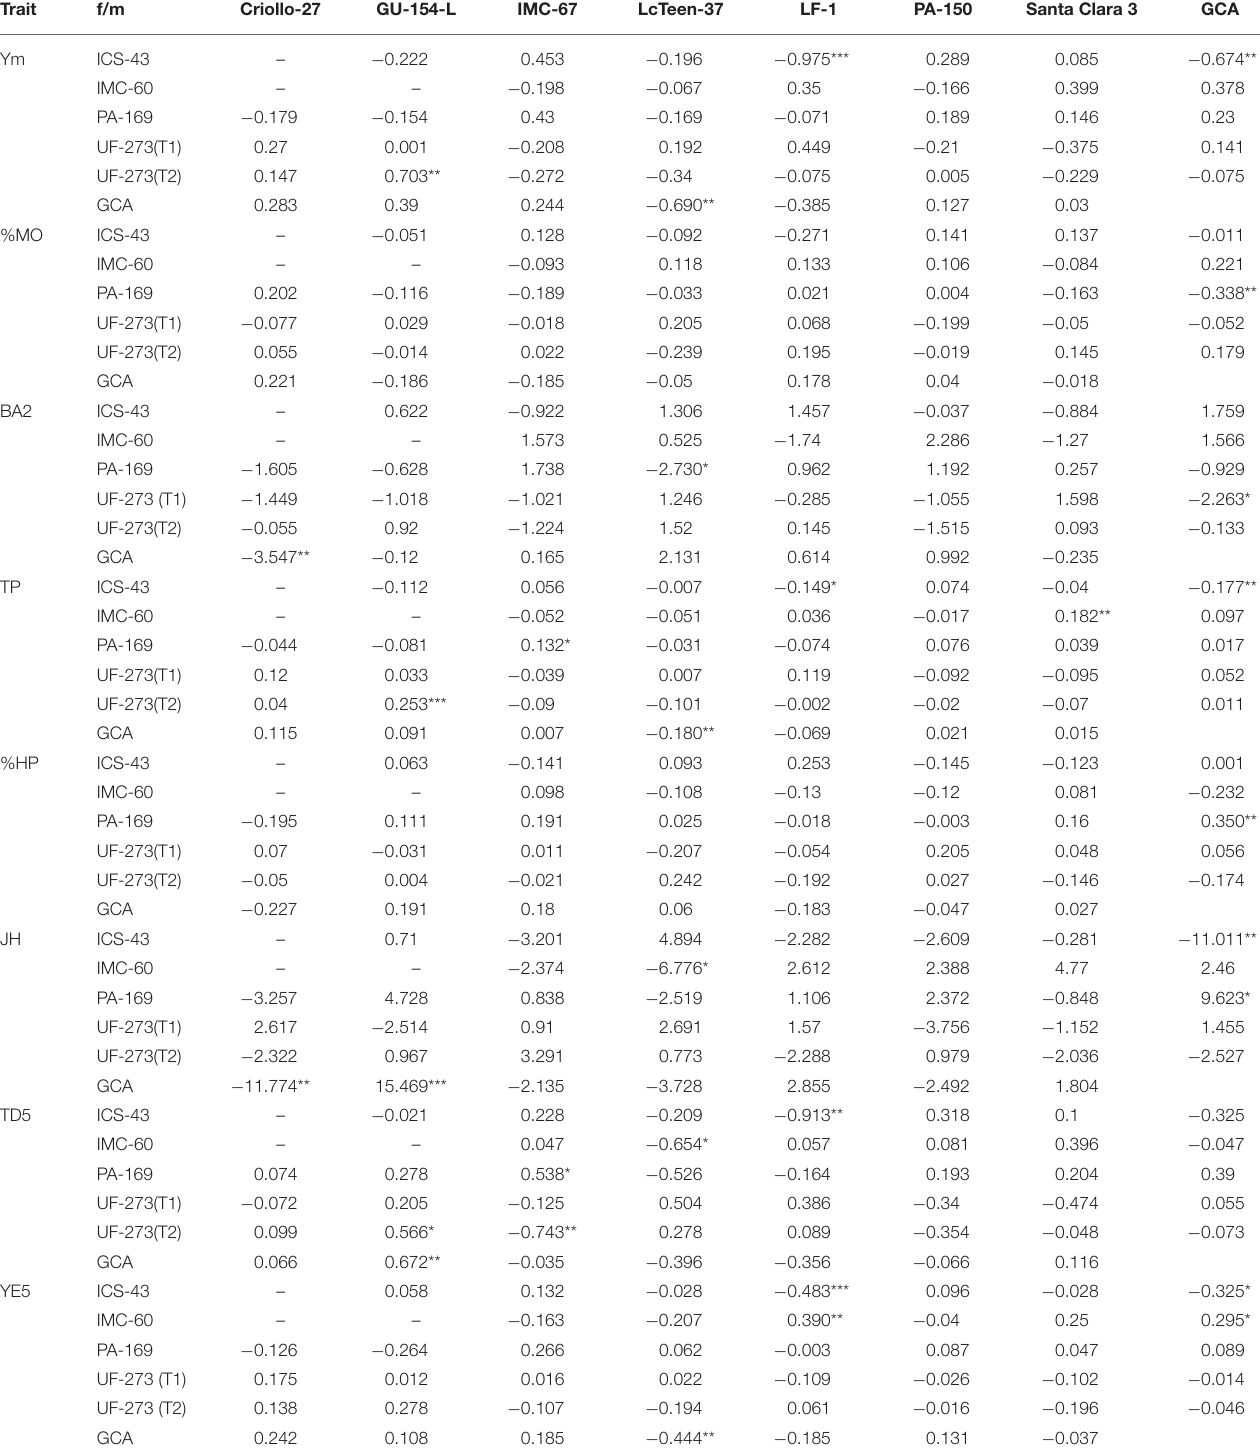
TABLE 4 | General and Specific Combining (GCA) abilities for parents in L7 for average yield (Ym), proportion of monilia infected pods (%MO), branch angle (BA2), total pods (TP), proportion of healthy pods (%HP), for jorquette height at 12 months (JH), trunk diameter at age 5 (TD5), and yield efficiency at age 5 (YE5) based on single-trait model